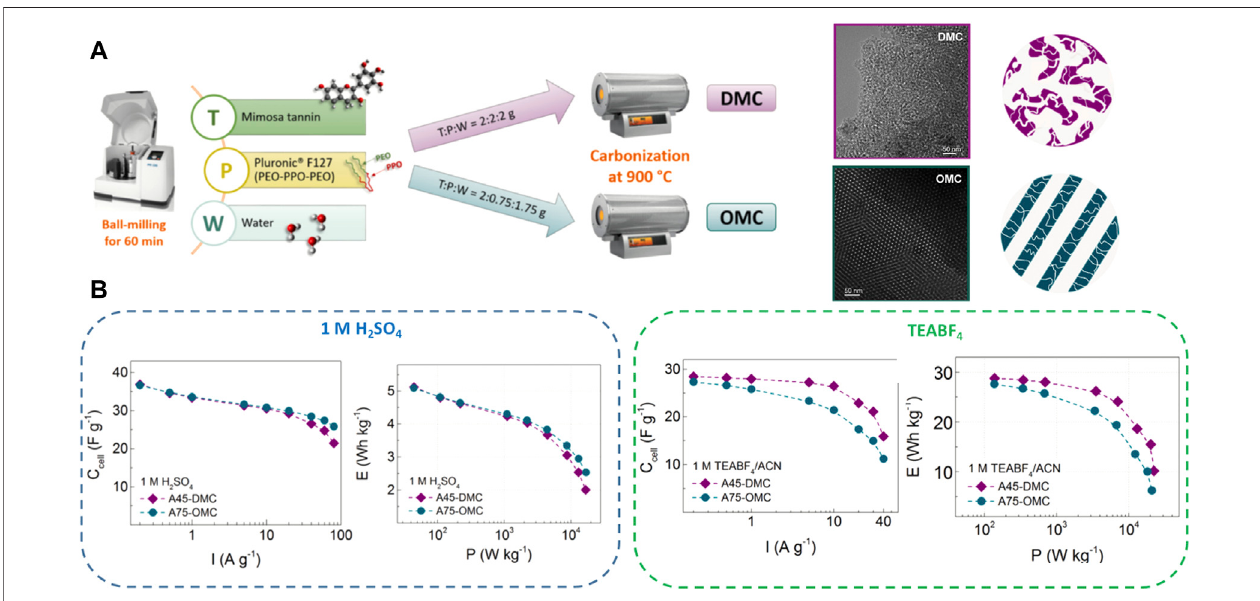
FIGURE 6 | (A) Schematic representations of the synthesis of ordered and disordered mesoporous carbons (OMC and DMC, respectively) by mechanochemical mesostructuration.TEMimagesandschematicporousstructureoftheresultantOMCandDMCmaterials. (B) Cellcapacitance (C cell )asafunctionoftheappliedcurrent and Ragone-like plots in aqueous (1M H 2 SO 4 ) and organic (TEABF 4 ) electrolytes. Adapted with permission from (Castro-Gutierrez et al.,